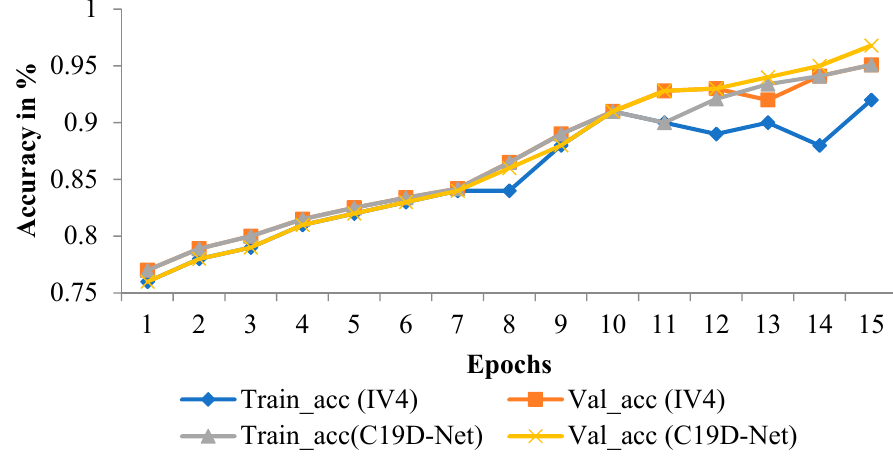
Figure 9. Accuracy graph of proposed C19D-Net with IncepttionV4. The yellow line of train_acc (C19D-Net model) will increase with the number of epochs. Before 10 epochs the accuracy increase in a small amount, but decrease at epoch 11 and after 11 the accuracy increases till the last epoch with maximum value. The blue line of train_acc (IV4 model) will increase or decrease before reaching a maximum